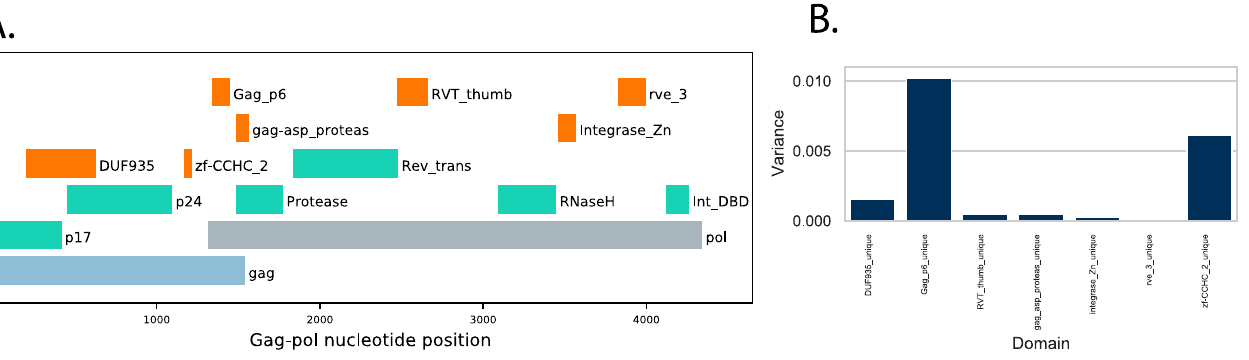
Figure 4. ( A ) Protein domains with variation across a query set of 32 HIV-1 Gag-Pol sequences. The HIV-1 Gag-Pol region is depicted, with open reading frames for gag (light blue) and pol (gray) indicated. The positions of HIV-1 Pfam domains with low variation (green) and the seven higher variation domains used here are colored in orange. ( B ) Variance of domain bit scores across the set of 32 query sequences.